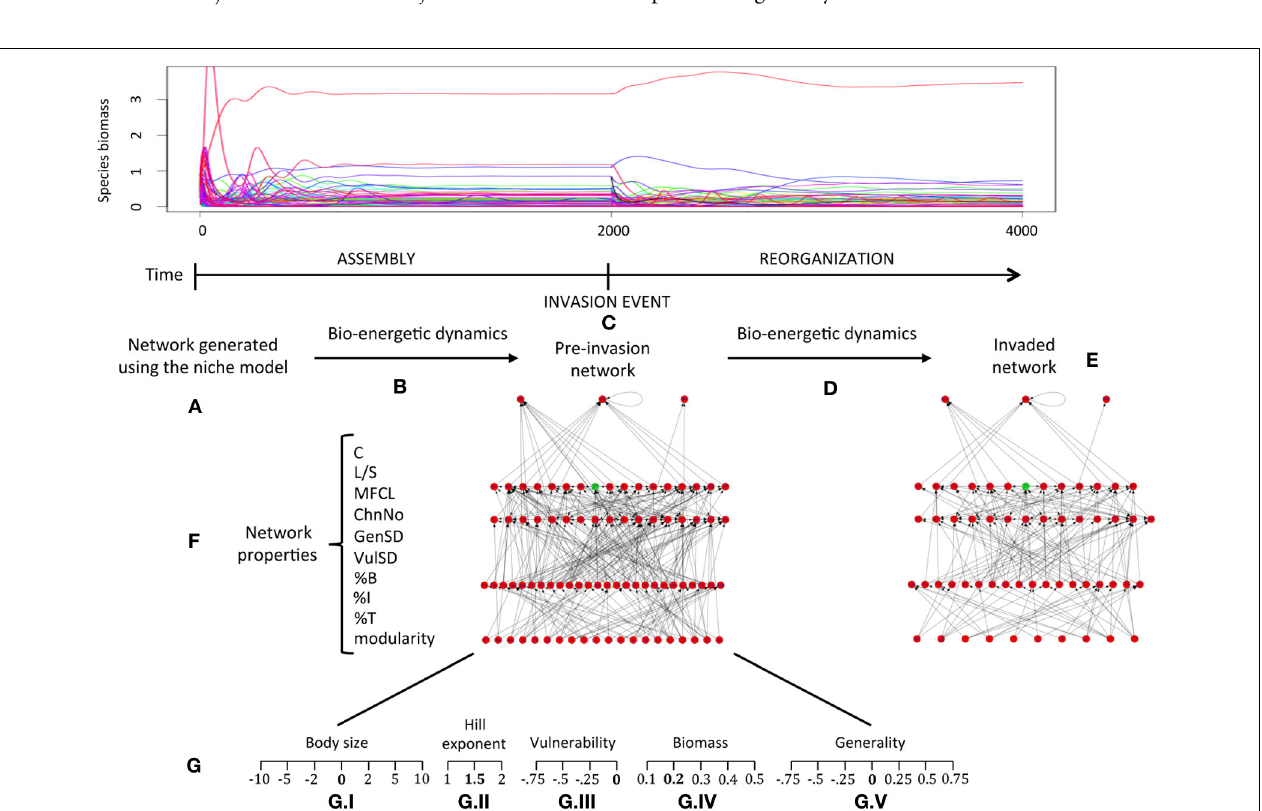
FIGURE 1 | Conceptual diagram of the in silico experiments performed. (A) Theinitialfoodwebstructureofthecommunityisgeneratedusingtheniche model. (B) Community dynamics through a transient period (from iteration 0 to 2000)aresimulatedusingthebio-energeticmodel(seetext).Communitiesthat are stable at time step 2000 are subject to invasion (C) . After invasion, the community evolves further 2000 time steps (to 4000) (D) until it reaches a new